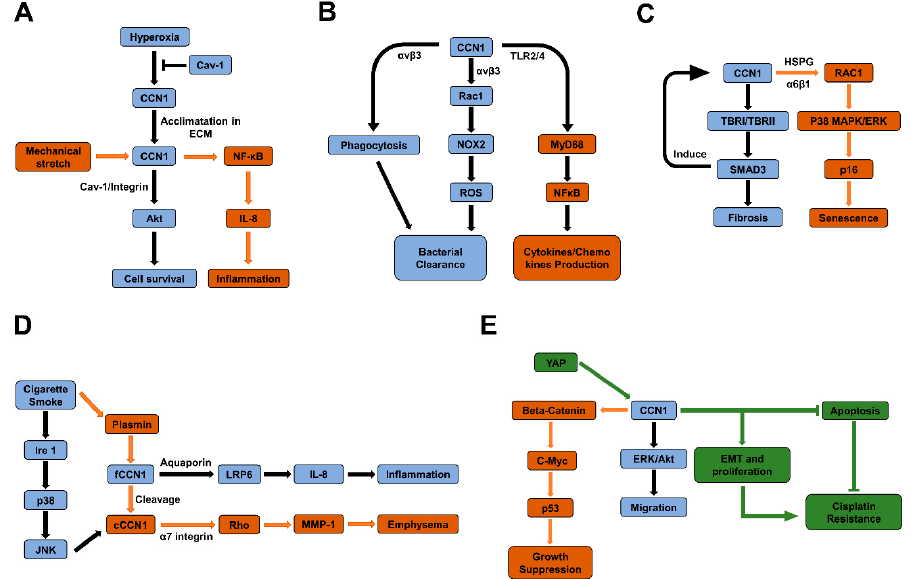
Figure 2. Schematic diagrams of signaling pathways mediate the pathogenesis of ALI in lung epithelial cells ( A ), pulmonary infection in macrophages ( B ), lung fibrosis in fibroblasts ( C ), COPD in lung epithelial cells ( D ), and lung cancer ( E ), respectively.